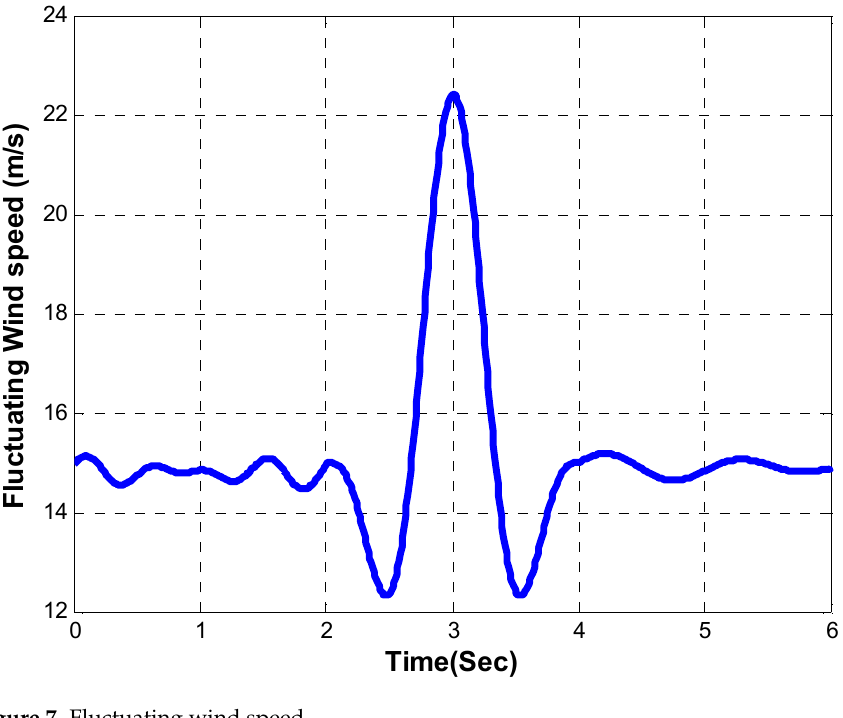
Figure 7. Fluctuating wind speed.